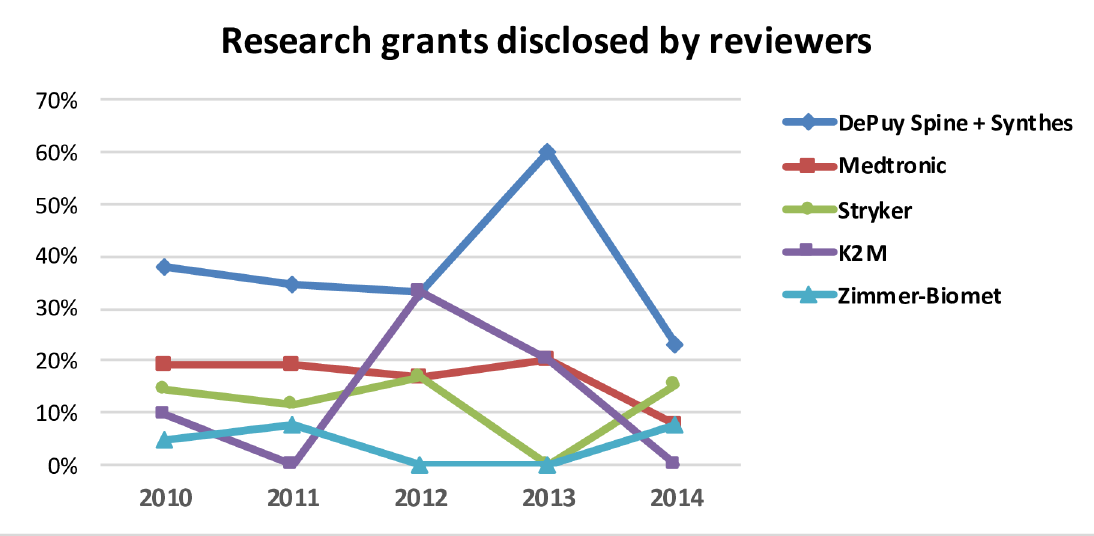
Fig 6. Distribution of research grants among the leading companies in relation to the total number of grants disclosed by the SRS and IMAST Program